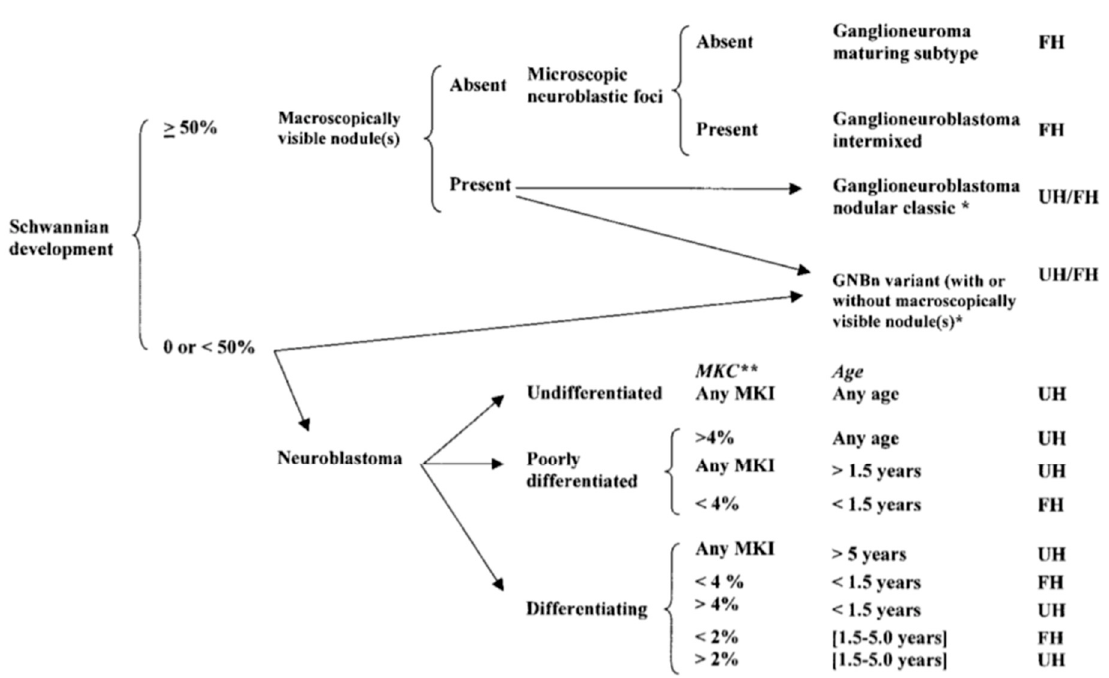
Figure 1. International Neuroblastoma Pathology Classification [3] (Reprinted with permission from